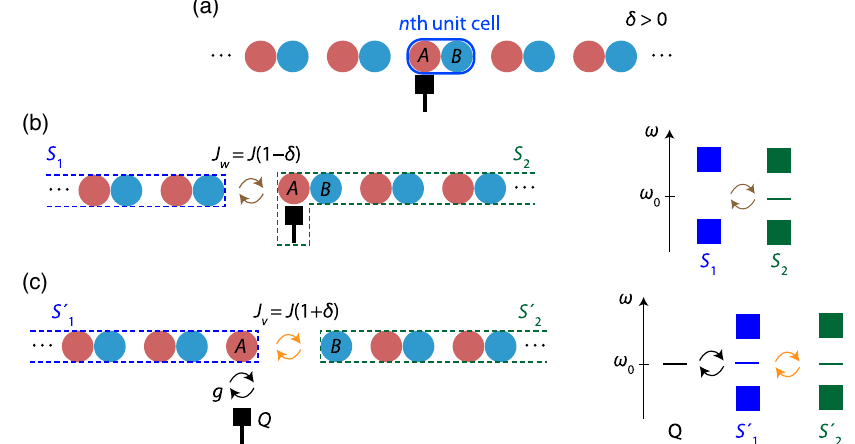
FIG. 12. Understanding the directionality of qubit-photon bound states. (a) Schematic of the full system consisting of an infinite SSH waveguide with a qubit coupled to the A sublattice of the n th unit cell and tuned to frequency ω 0 in the center of the MBG. Here we make the unit cell choice in which the waveguide is in the trivial phase ( δ > 0 ). (b) Division of system in (a) into two subsystems S 1 and S 2 in description I. (c) Division of system in (a) into three subsystems [qubit ( Q ), S 0 1 , S 0 2 ] in description II. For panels (b) and (c), the left-hand side shows the schematic of the division into subsystems and the right-hand side illustrates the mode spectrum of the subsystems and the coupling between